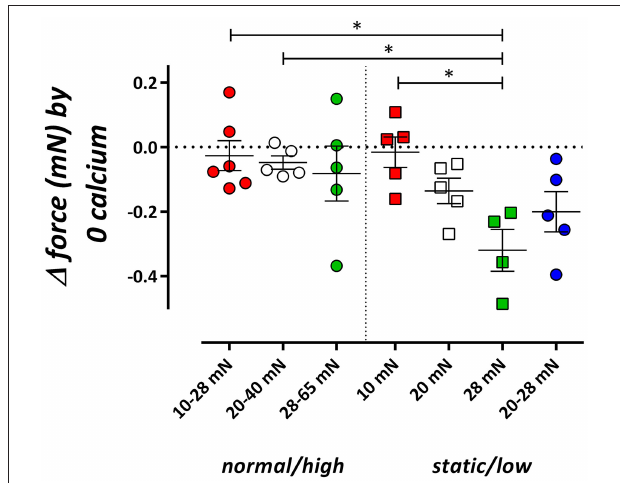
FIGURE 2 | Influence of cyclic stretch conditioning on isometric force upon Ca 2 + removal from the extracellular solution. Isometric force was measured at 10, 20, and 28mN in segments, which were previously conditioned at 10–28, 20–40, or 28–65mN cyclic stretch (normal/high) or which were continuously